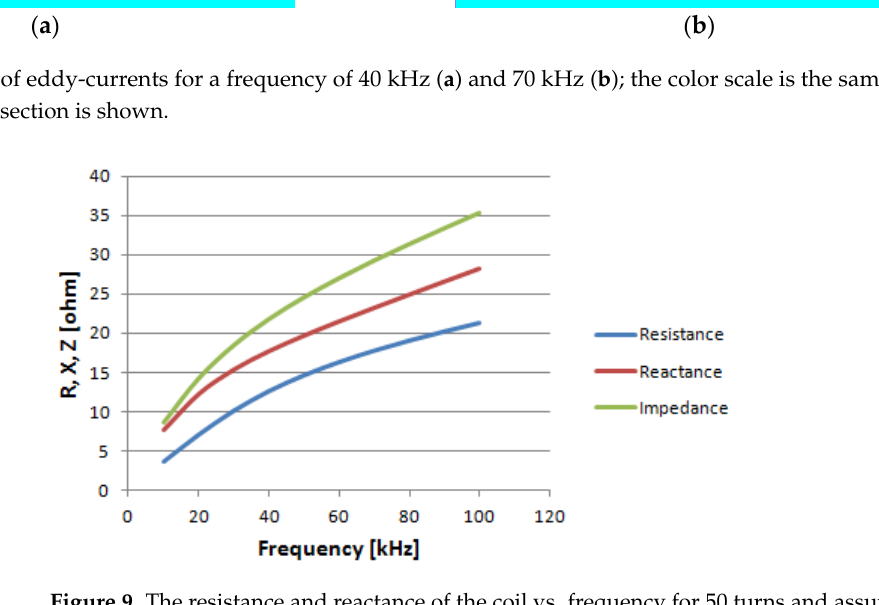
Figure 9. The resistance and reactance of the coil vs. frequency for 50 turns and assumed coil length 150 mm based on finite elements calculations.